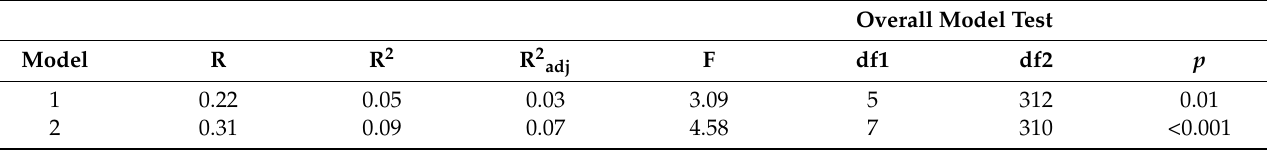
Table 6. Overall Model Test for Emotional Exhaustion.